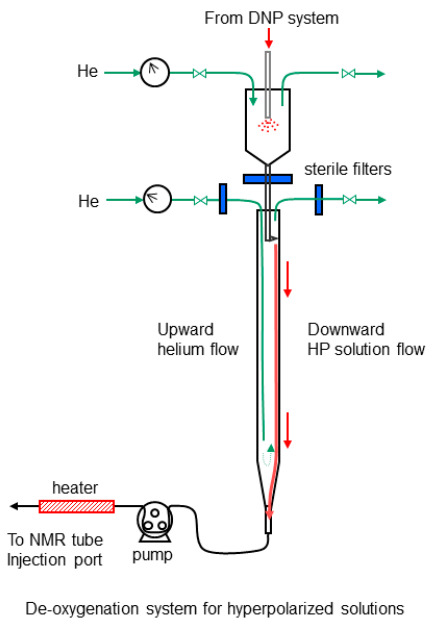
Figure 10. System used for injecting oxygen depleted solutions containing hyperpolarized substrates into the NMR tube. Two stages of helium sparging were used to ensure thorough oxygen removal. Sterile filters were used for both the helium and the hyperpolarized solutions before the second